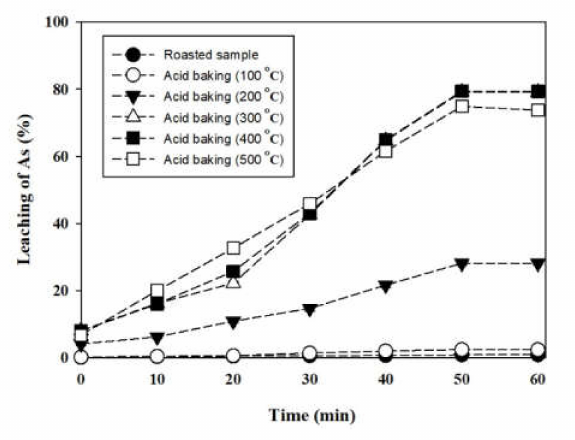
Figure 5. Leaching of As in the hot water leaching as a function of